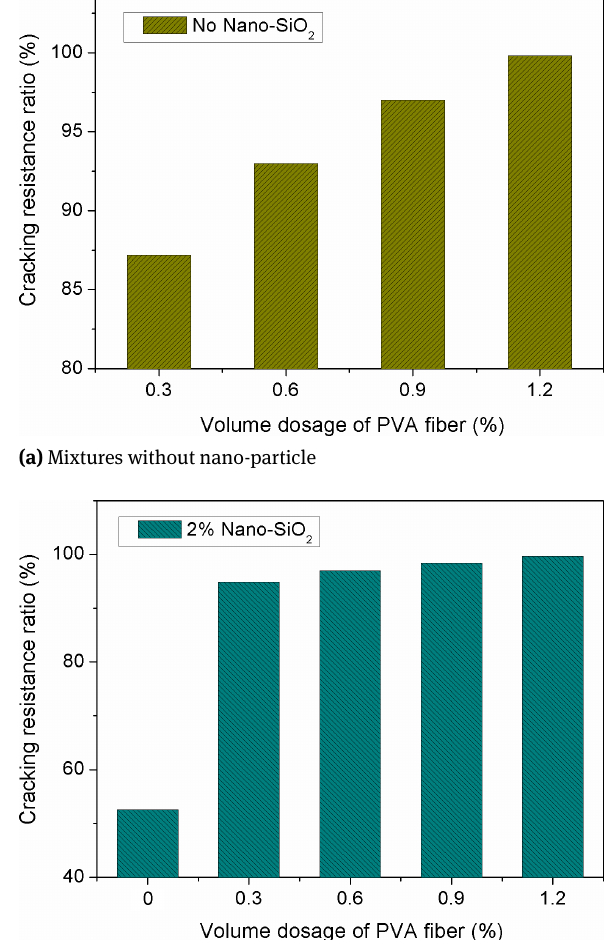
obviouslyincreased crackingresistance ratioof thecemen- titious composite. As is seen from Figure 4(a), for the ce- mentitious composite without nano-particles, the amount of the net cracking resistance ratio increase caused by 0.3% PVA fibers was about 66%, which was much larger than the net increase of cracking resistance ratio of cemen- titious composite containing 2% nano-SiO . For both se- 2 ries mixtures, the cementitious composite containing 1.2% PVA fibers exhibited the highest cracking resistance ratio increase. As is found from Figure 4(b), for